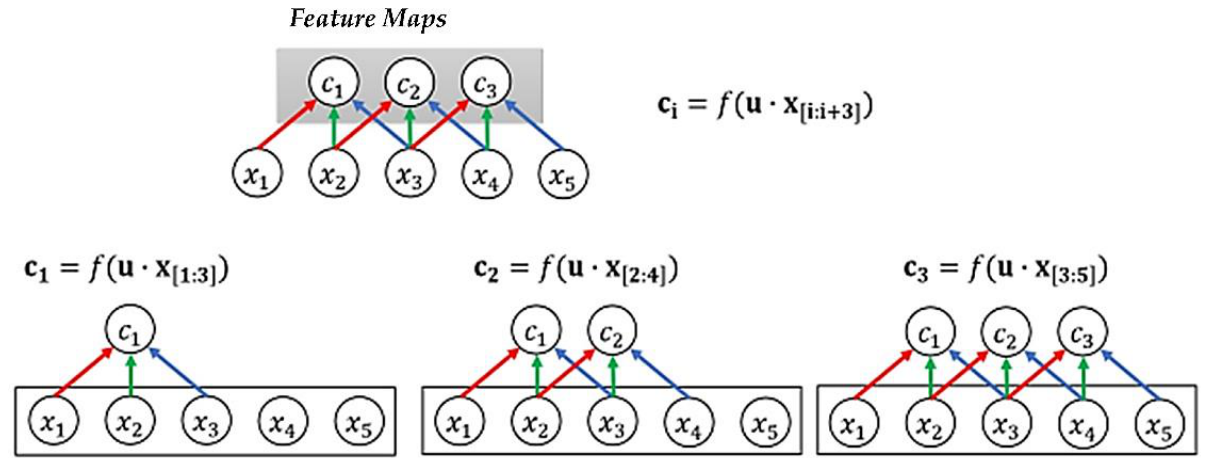
Figure 4. Generation of feature maps in the convolutive layers.